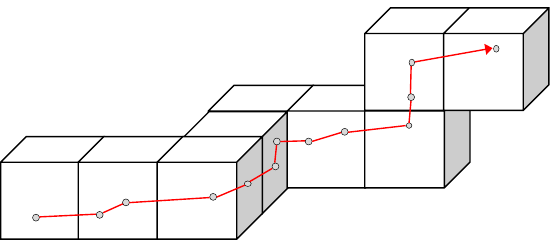
Figure 6. Index trajectory based on HGST subsection model (the dots are the collected trajec- tory points, and the red line is the formed trajectory, which can be enveloped by several spatio- temporal cubes).